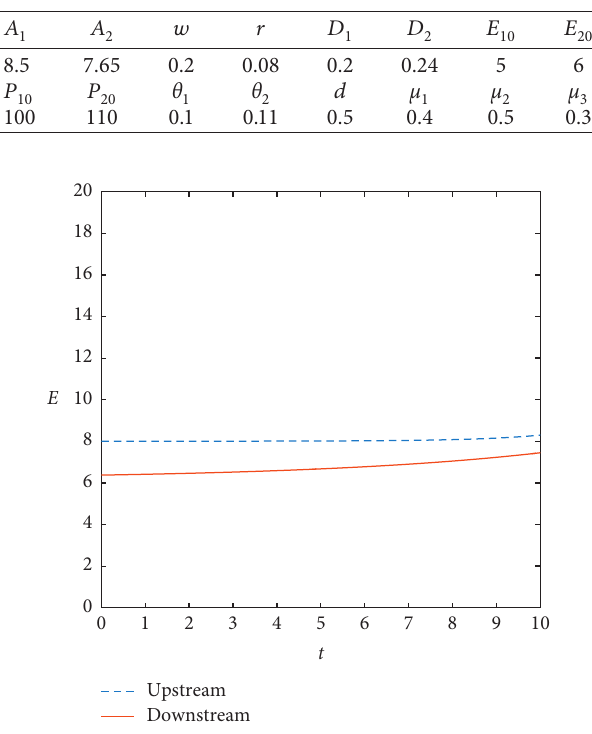
Figure 1: Optimal trajectory of pollution emission under non- cooperation when T � 10.